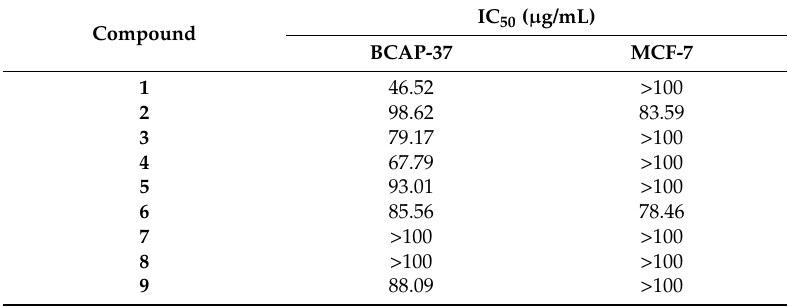
Table 1. Half maximal inhibitory concentration (IC 50 ) of nine compounds on BCAP-37 and MCF-7 breast tumor